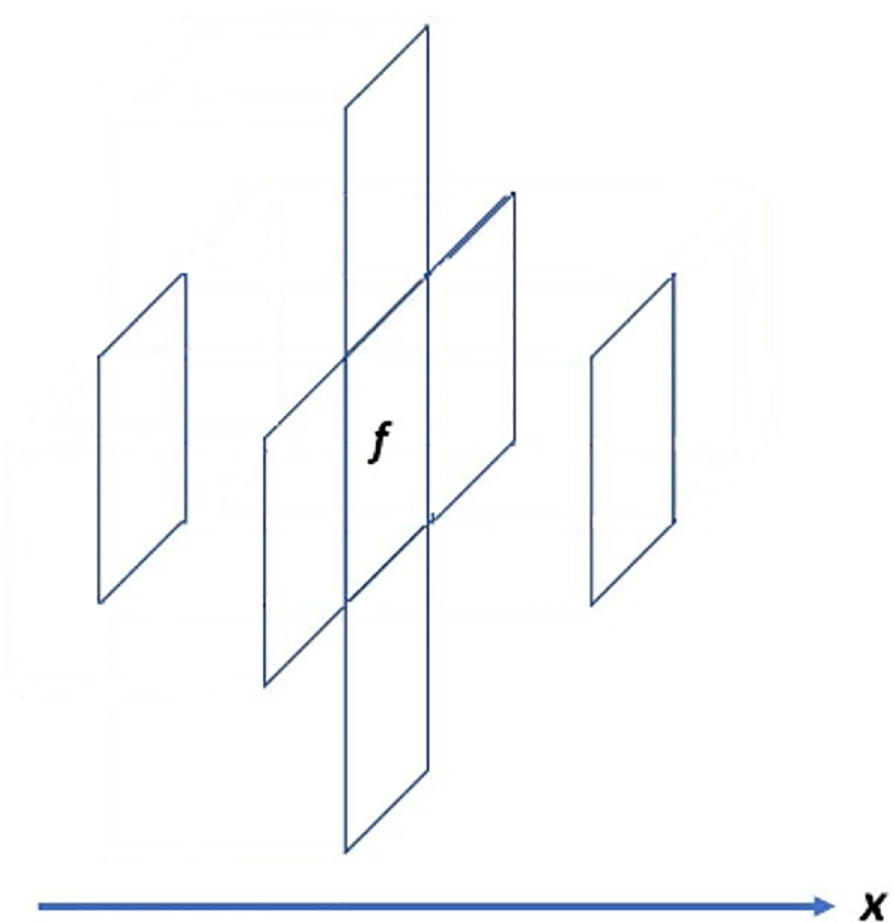
Fig 2. Discretization of the variable u in Eq (2). Suppose Eq (2) is discretized on the x -direction face f , and then the x variable u x is discretized on the face f and the six faces adjacent to f